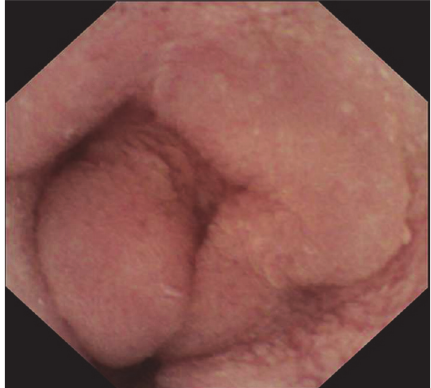
Figure 3: Video capsule endoscopy (VCE): One image from small intestine: No polyps